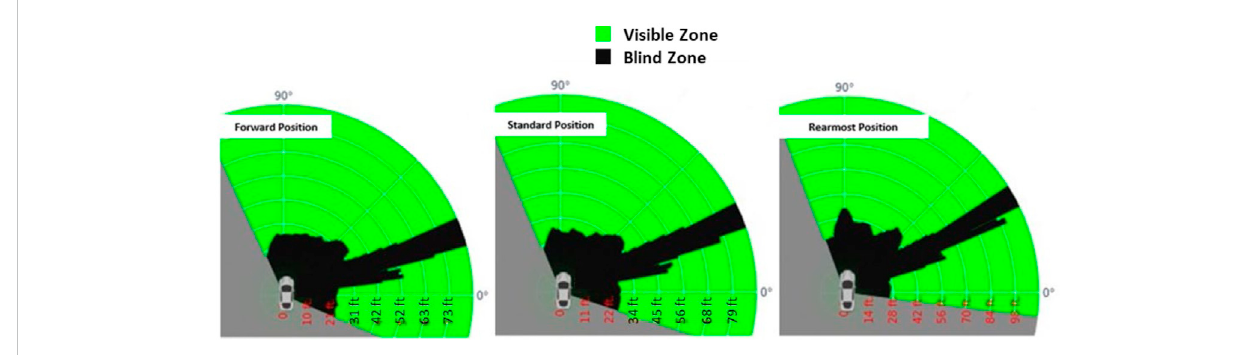
FIGURE 6 Predicted blind zone generated by the VIEW app for the forward, standard, and rearmost seating position.